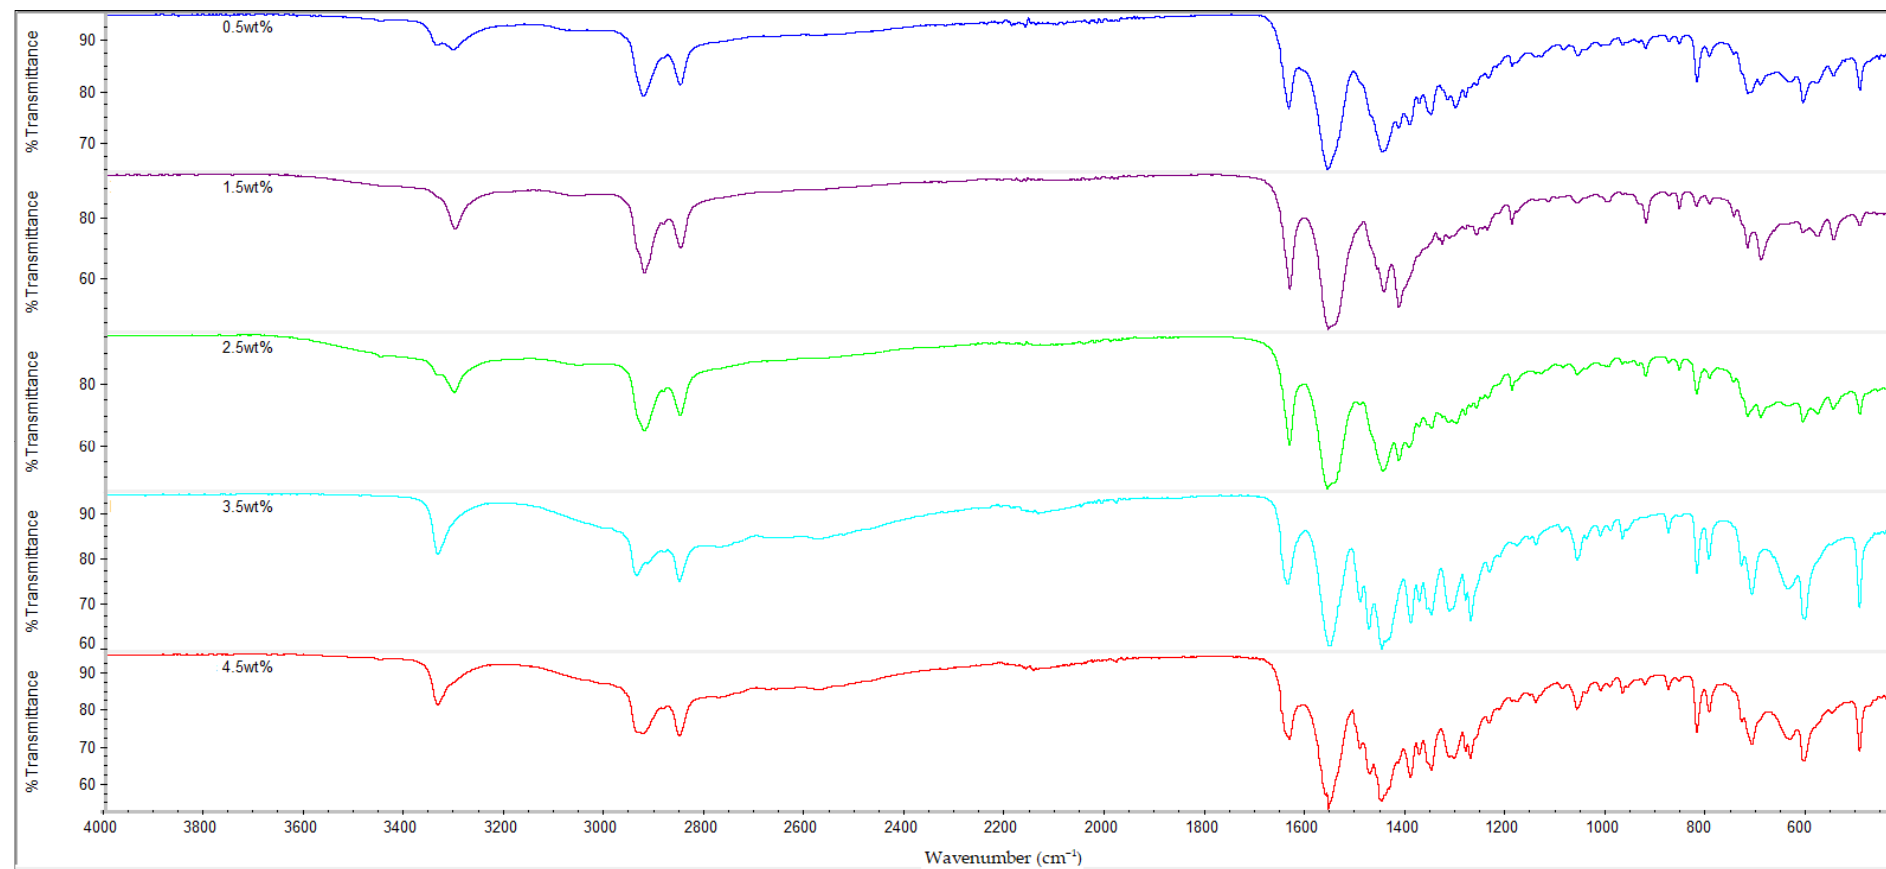
Figure 11. FTIR Spectra for Nylon 610 Nanocomposites with Graphite Nanosheets Treated at 175 °C and − 0.1 MPa.